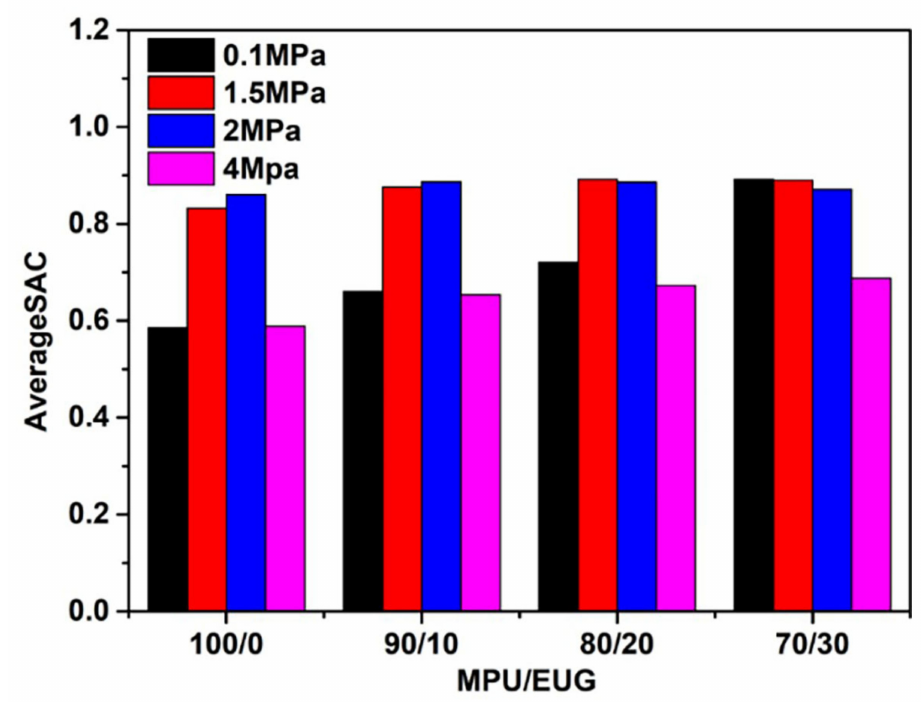
Figure 7. The average sound absorption coefficient of various MPU/EUG composites in the frequency domain of 4.5–8